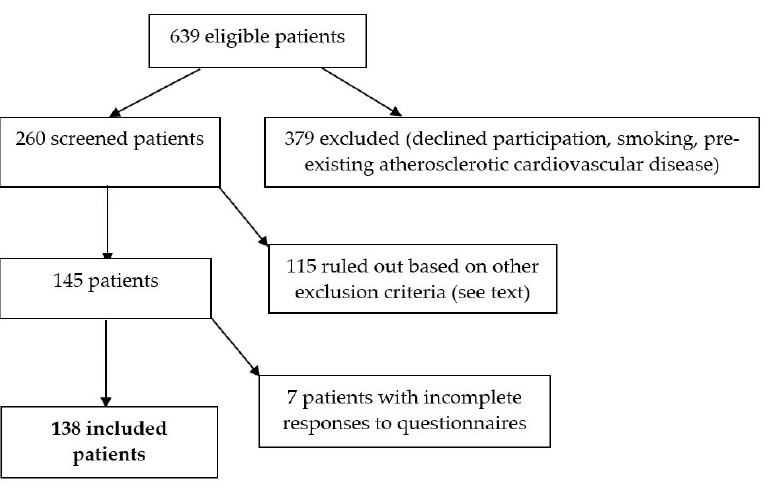
Figure 1. Overview of the patient enrollment process.